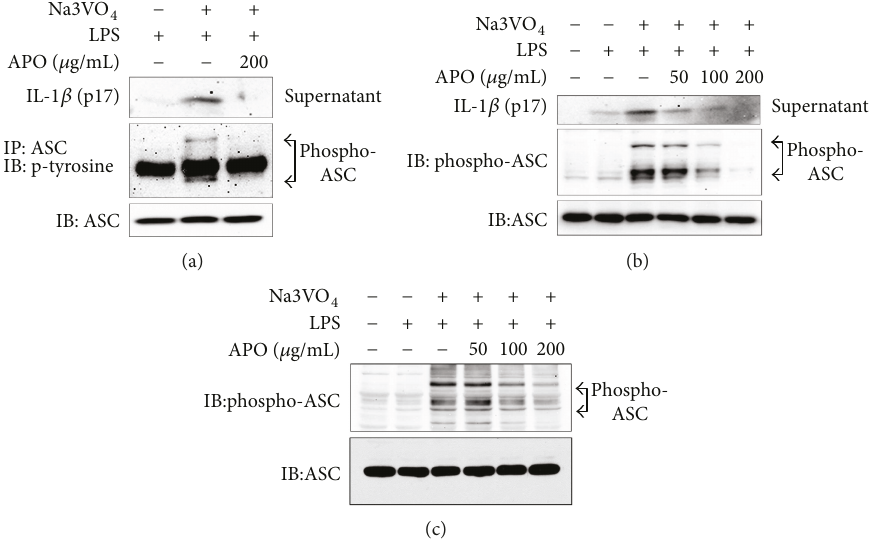
Figure 5: Inhibitory e ff ect of APO on ASC phosphorylation. J774A.1 cells or BMDMs were stimulated with LPS (37 ng/mL) for 8 h and treated with sodium orthovanadate (1 mM) for 3h. The ASC was enriched by immunoprecipitation. (a) Immunoblot analysis of phosphor-ASC in immunoprecipitates using antibody to phosphorylated tyrosine. ASC was blotted to validate the e ffi ciency of the immunoprecipitation. (b-c) Immunoblot analysis of phospho-ASC in whole cell lysates of (b) J774A.1 or (c) BMDMs using antibody against phospho-speci fi c ASC. IL-1 β release in cell culture medium was also determined to con fi rm in fl ammasome activation. LPS, lipopolysaccharide; APO, A. princeps extract; Na VO , sodium 3 4